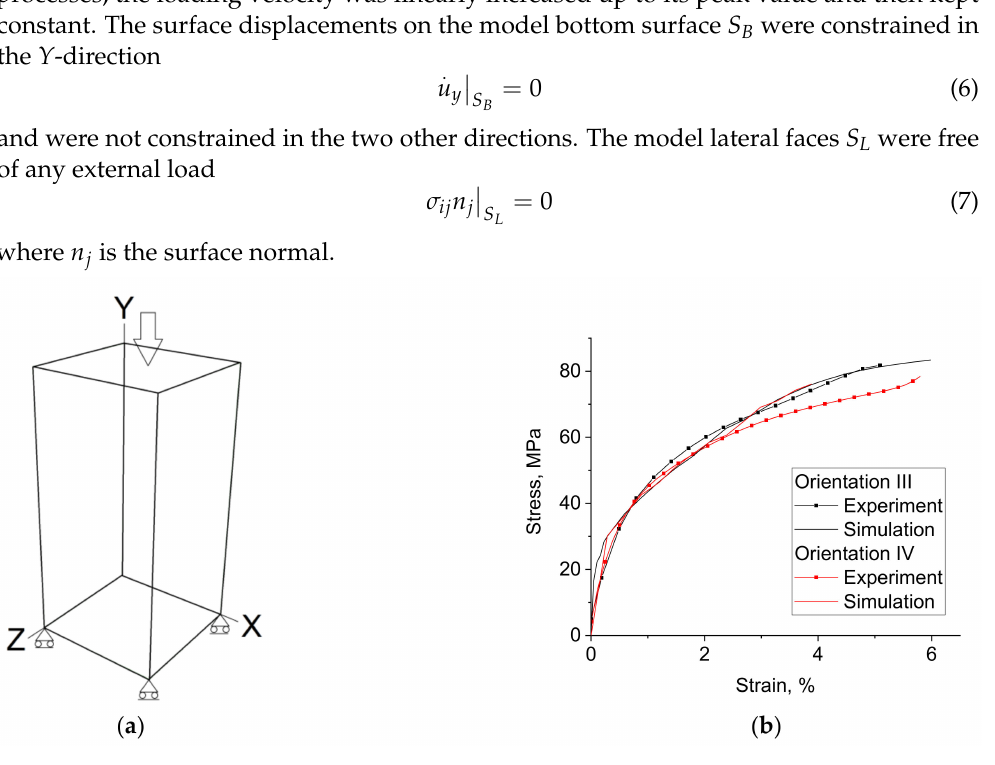
(cid:0) (cid:1) (cid:0) (cid:1) 112 111 (Orientation IV)